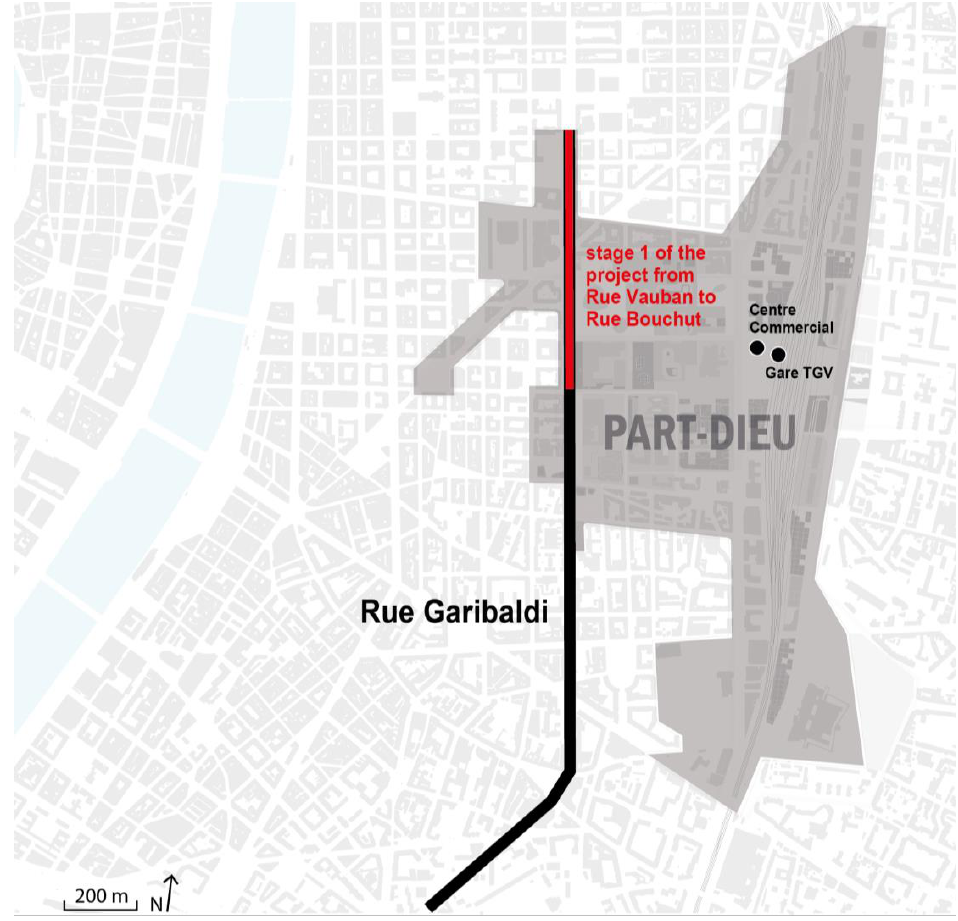
Figure 2. General view of Lyon Part-Dieu business district, realised by authors. Sources: Grand Lyon, La Metropole